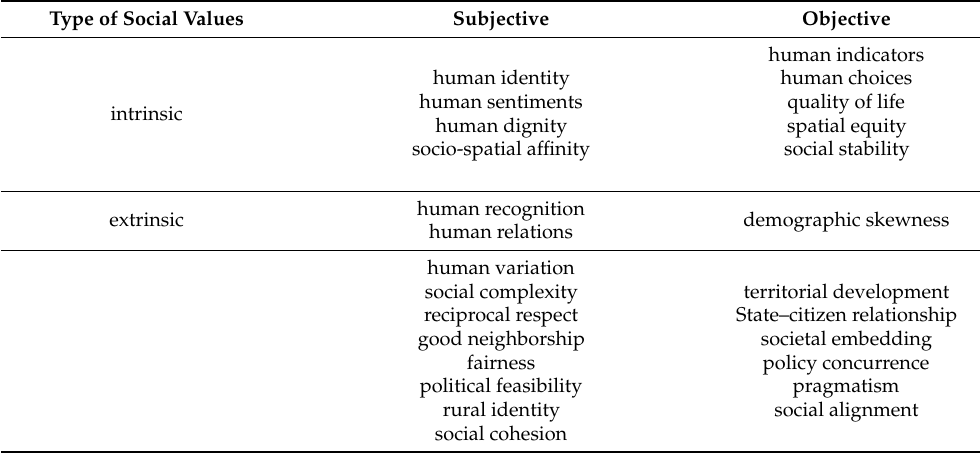
Table 2. Classification of social